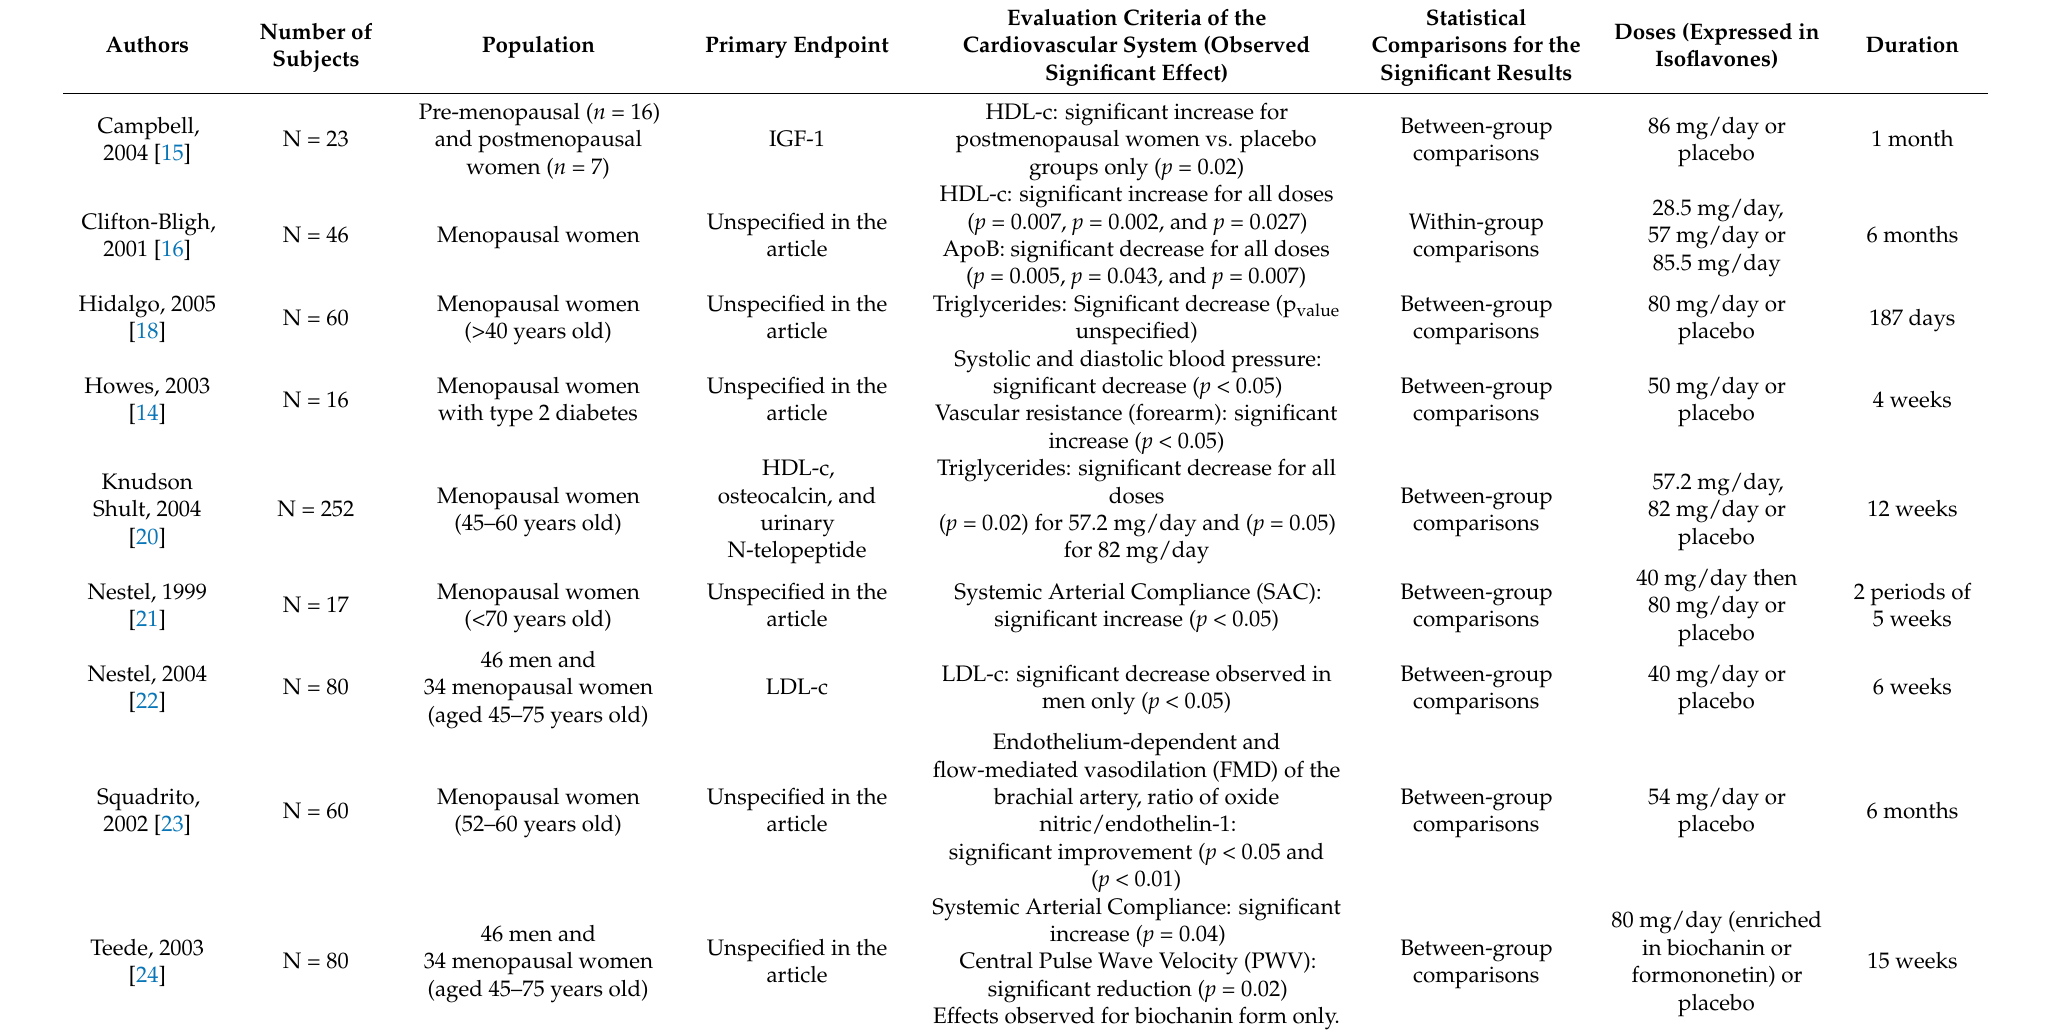
Table 5. Characteristics of the most relevant studies regarding the pending claim for Trifolium pratense